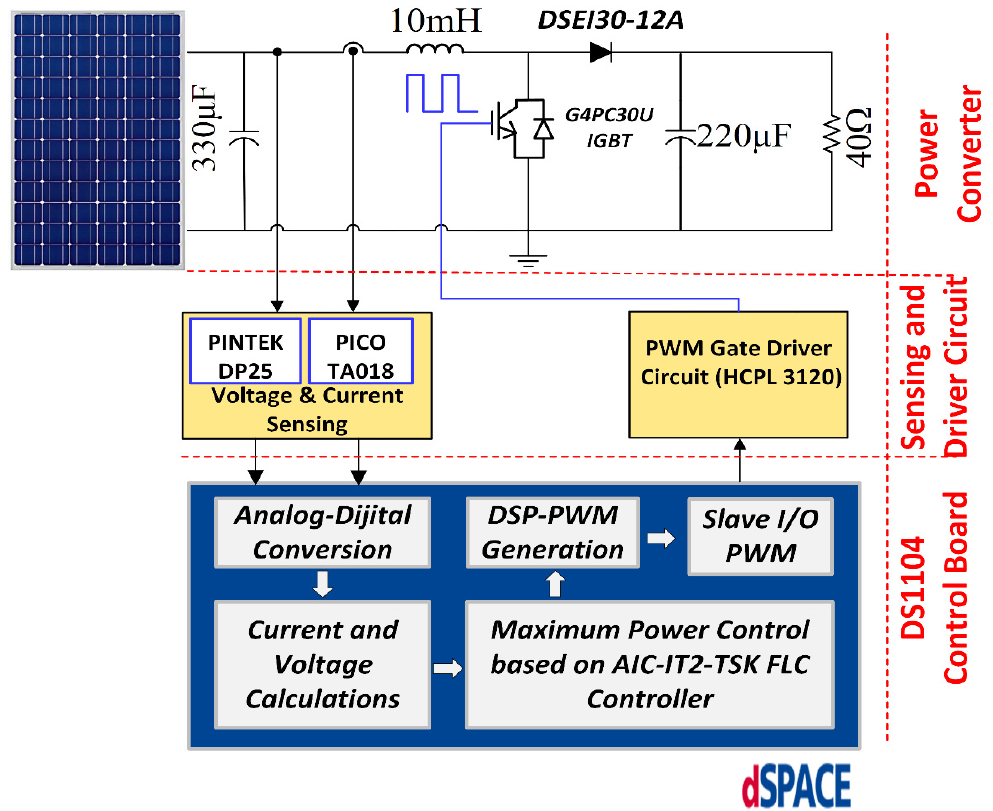
Figure 13. Schematic presentation of experimental study.